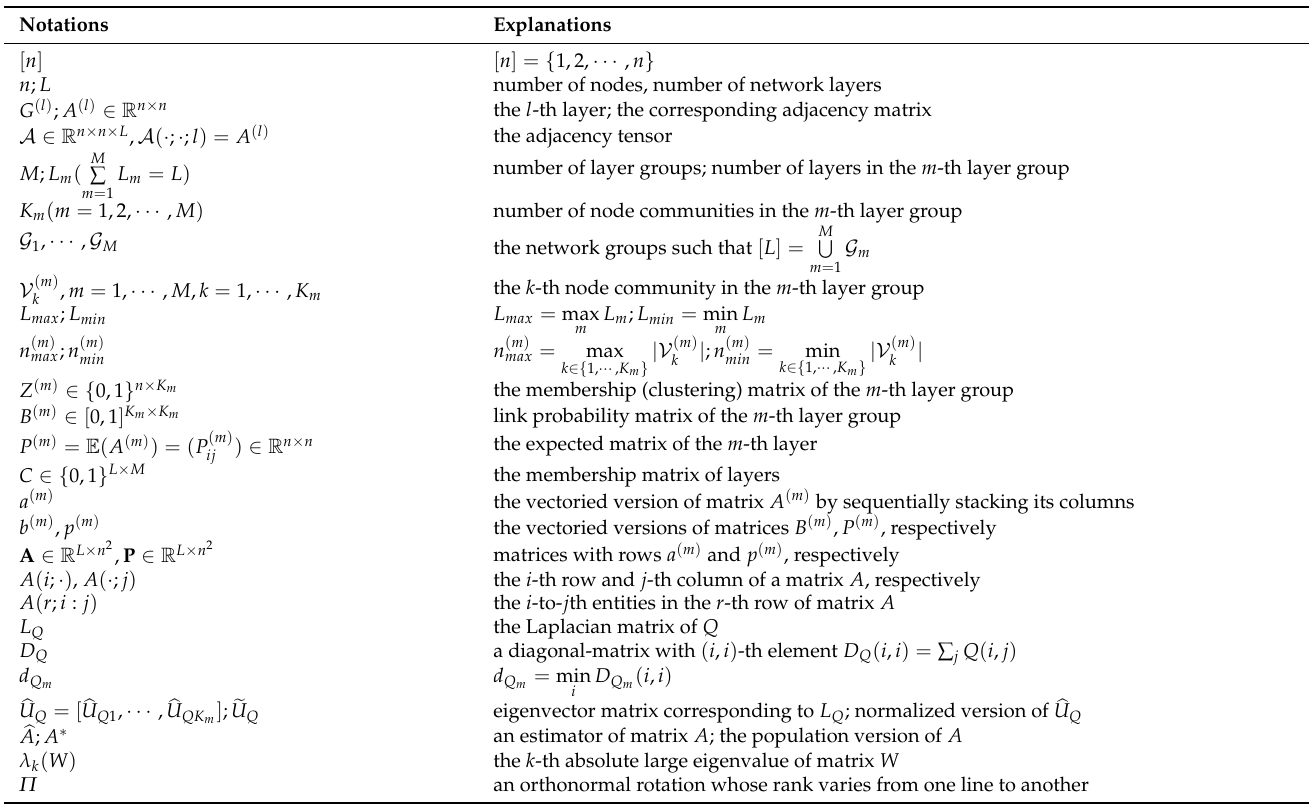
Table 1. Notation